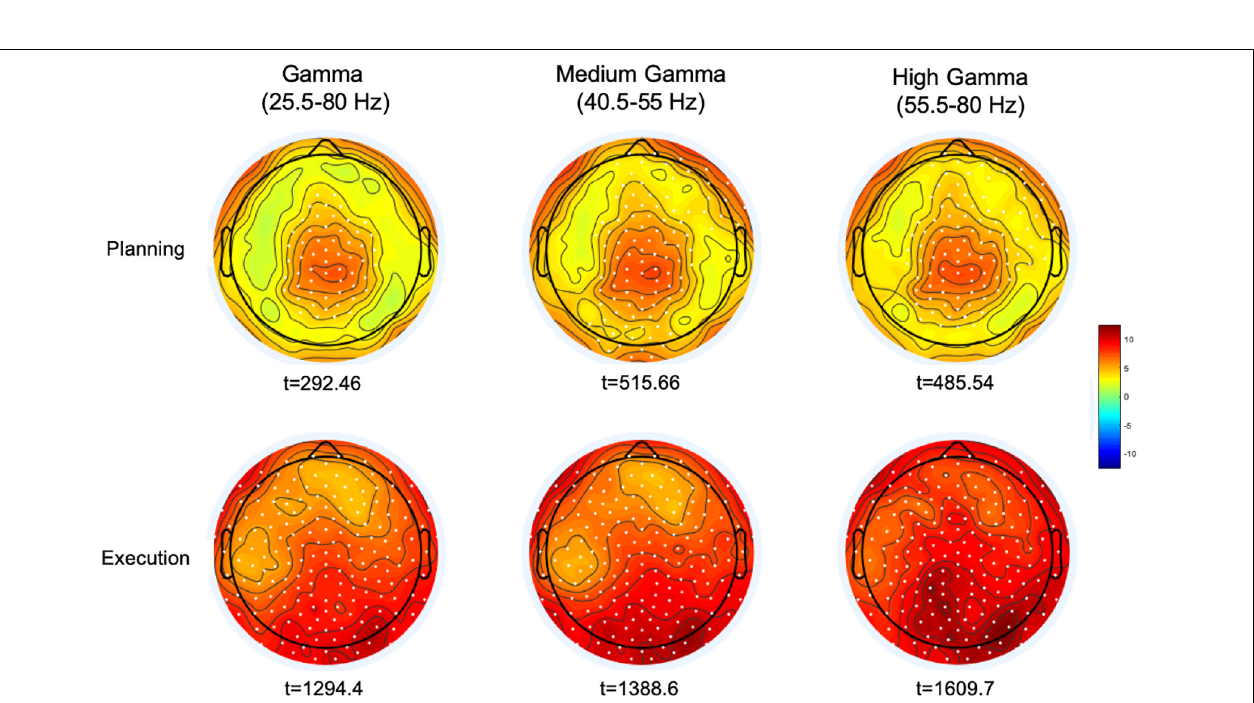
FIGURE 2 | Monte Carlo cluster-based permutation t-statistic of the difference between gamma oscillatory activity and the average spectral power during movement planning and execution. Dots indicate significant clusters of electrodes ( p ≤ 0.0005). The color bar represents the magnitude of the t values.